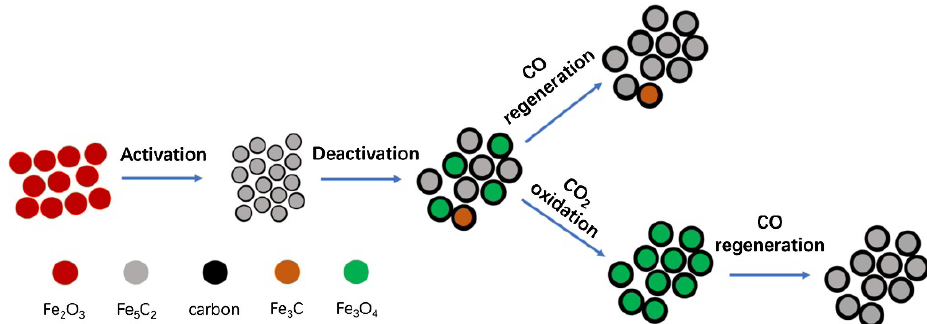
Figure 9. Structure evolution of Fe catalyst in CO 2 hydrogenation during its life cycle. Reprinted with permission from ref. [61] . Copyright 2019 Elsevier.